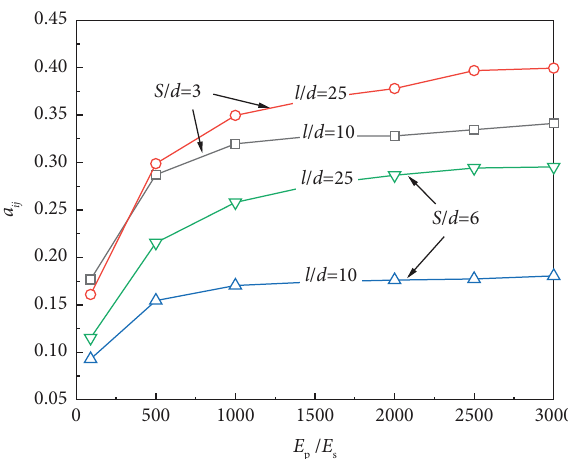
Figure 2: Infuence of the k on pile-pile interaction factor ( S / d � 3, S / d � 6).